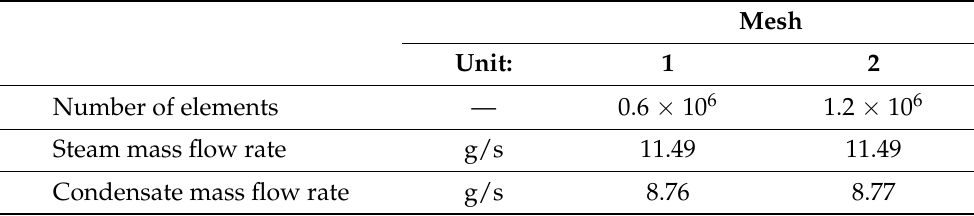
Table 1. Mesh independence